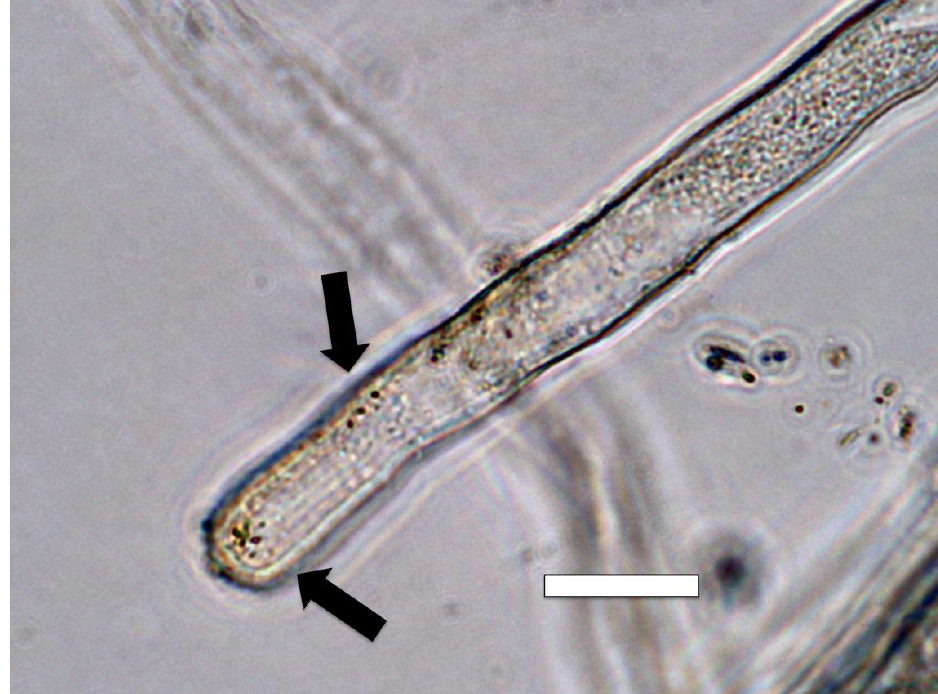
Figure 11. Intracellular bacteria (arrows) in Poa reptans root hairs stained for nitric oxide (brown color) using 0.1% iron sulfate acidified with sulfuric acid. The brown iron–nitric oxide complex is present around bacteria as a brown pigmentation (arrow) with the highest concentration very close to bacteria (bar = 15 µm).